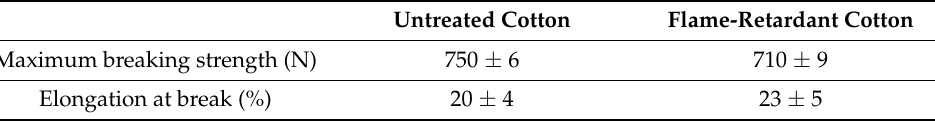
Table 1. Tensile characteristic